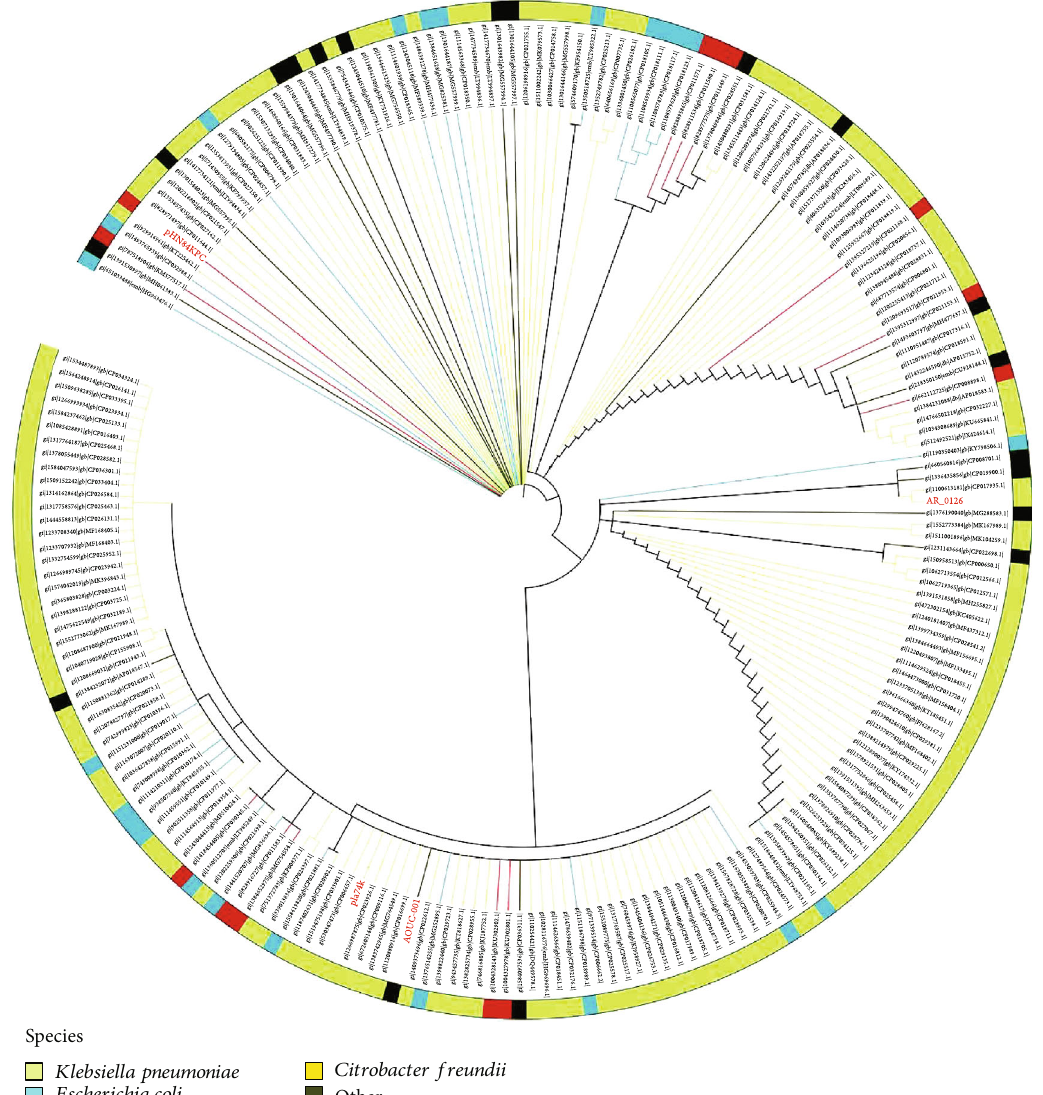
Figure 3: Phylogeny of backbone sequences of IncR